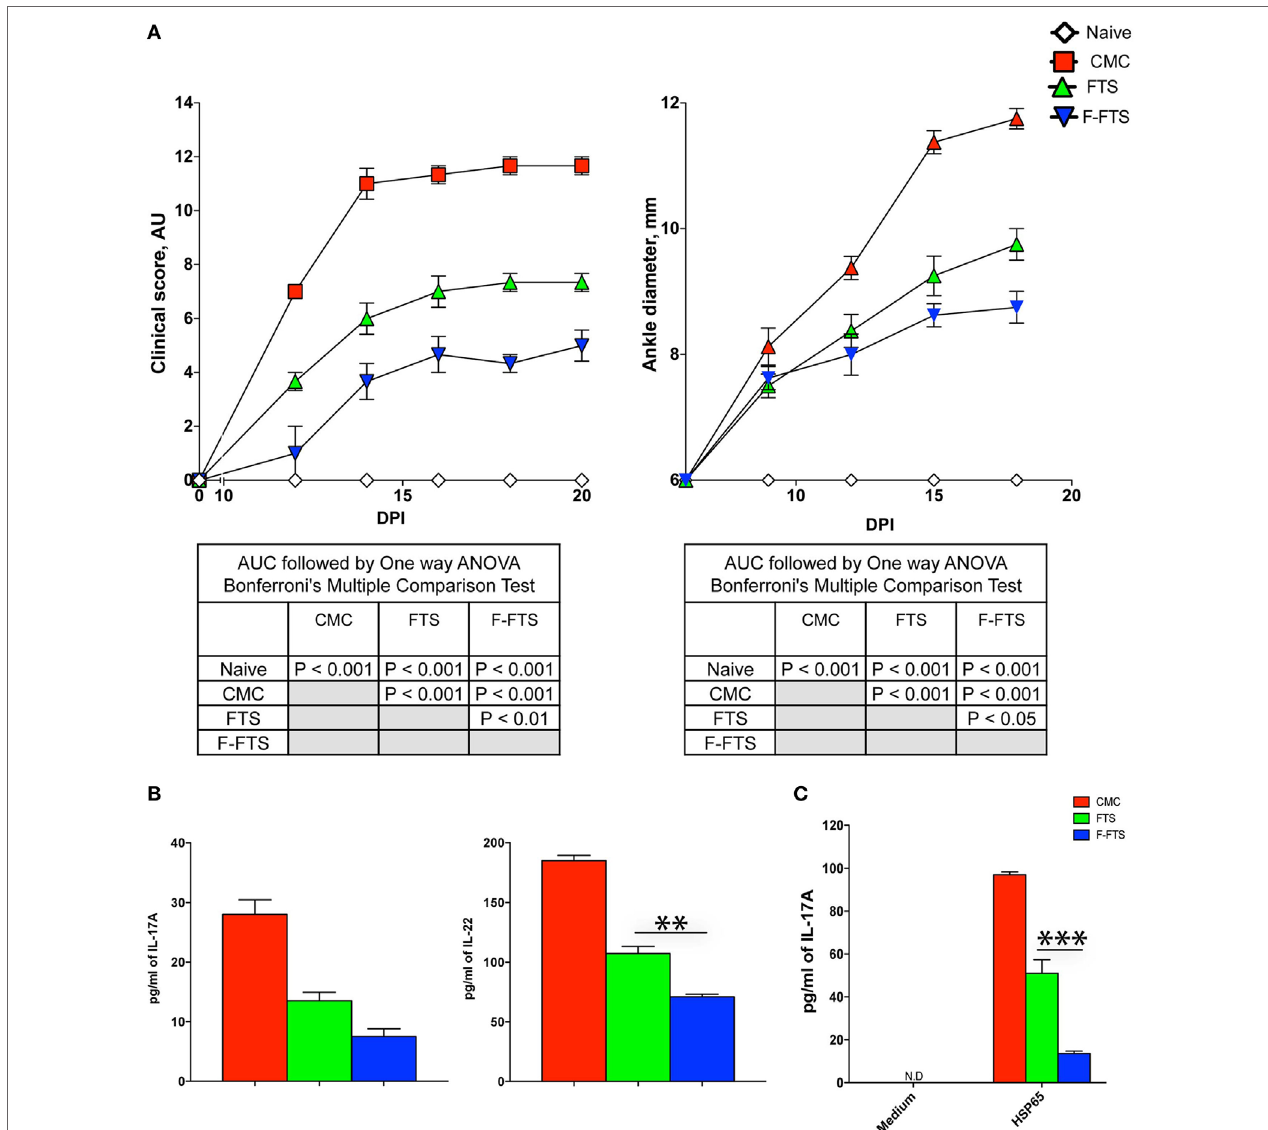
FigUre 6 | Fluoro-FTS (F-FTS) is significantly more effective than farnesylthiosalicylic acid (FTS) in attenuating multiple outcome measures of AIA. (a) Rats immunized with CFA were treated starting day + 1 with either oral FTS (100 mg/kg), F-FTS (60 mg/kg), or 0.5% carboxymethyl cellulose (CMC) vehicle solution. Arthritis severity was graded by clinical scores (left panel) and ankle diameter (right panel). Statistical analysis of the AUC of the effect of the treatments on the clinical outcomes was done by one way ANOVA with post hoc Bonferroni’s multiple comparison test, and the results are summarized in the table insets. (B) Sera from rats treated with either CMC, FTS, or F-FTS ( n = 5 per group) were collected at day + 14 and analyzed for IL-17A and IL-22 levels by readymade ELISA kits. (c) In paralleled, single cell suspensions from draining LNs and spleen of the various rats were stimulated with Bhsp65 (5 µg/ml) of or vehicle and cultured for additional 72 h. At culture termination, we analyzed the supernatants for the levels of Bhsp65-induced 17A secretion by ELISA. One representative experiments out of two performed. Bar graphs depict mean ± SD. Statistical significance was assessed by the Student’s t -test (* P ≤ 0.05, ** P ≤ 0.01, and *** P ≤